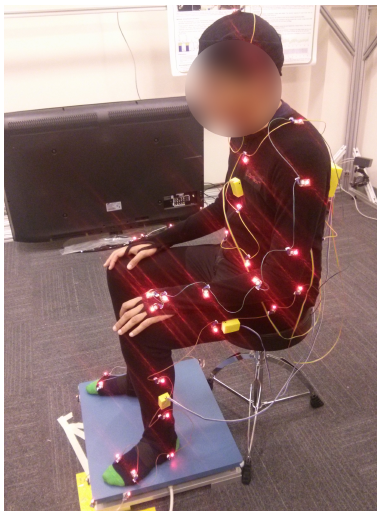
Figure 3: Experimental setup